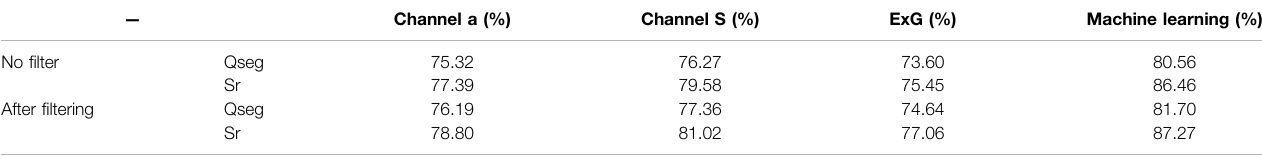
TABLE 2 | Comparison on accuracy of mangrove vegetation image segmentation algorithms.